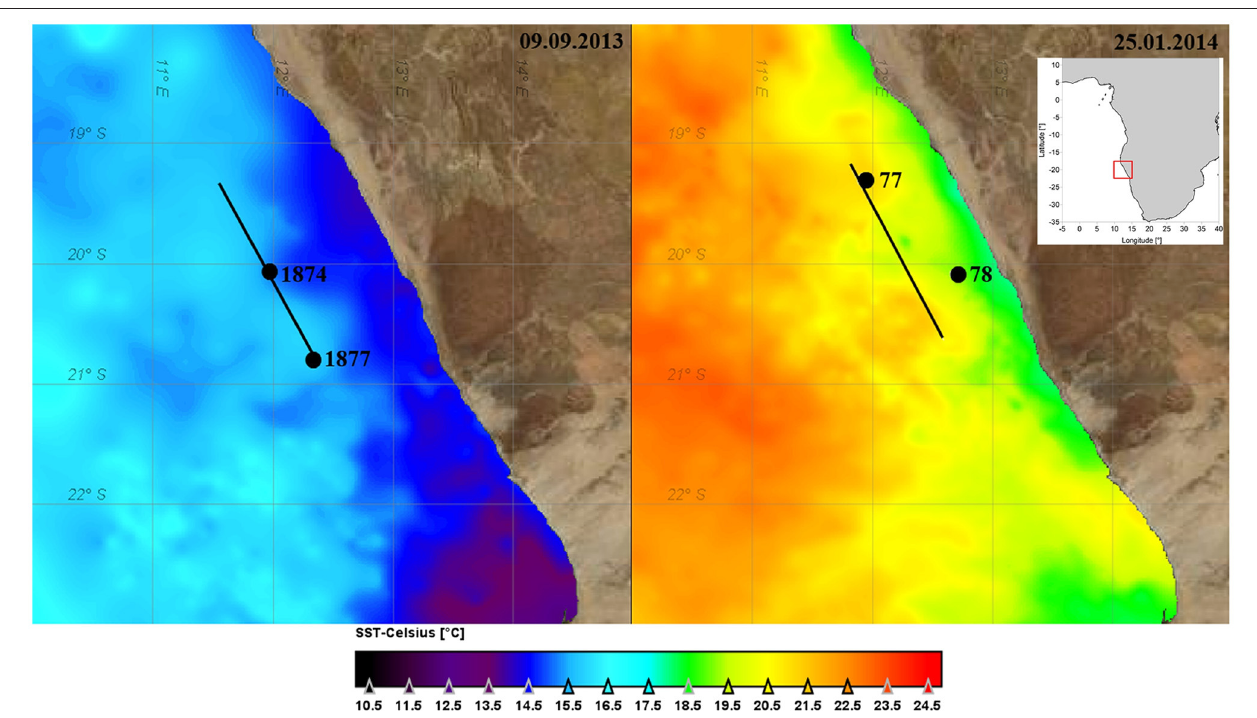
FIGURE 1 | Map of the investigation area with sea surface temperature (SST) on 9 September 2013 and 25 January 2014 derived from GHRSST Level 4 data set (JPL MUR MEaSUREs Project, 2010). The positions of the stations for filling the tanks are